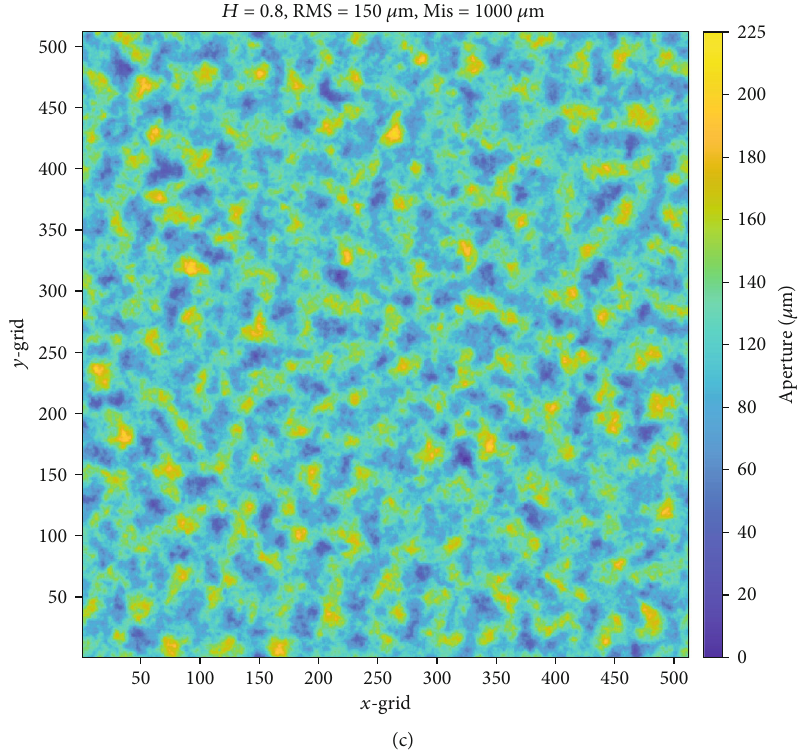
Figure 15: E ff ect of the RMS value on the aperture fi eld. H = 0 : 8 and λ = 1000 μ m . The scale of the color bar is proportional to the RMS c value. The number of grids in the x and y directions is 512. (a) Aperture fi eld when RMS = 50 μ m , which corresponds to surface pair 2 in Table 2; (b) aperture fi eld when RMS = 100 μ m , which corresponds to surface pair 6 in Table 2; (c) aperture fi eld when RMS = 150 μ m , which corresponds to surface pair 7 in Table 2. The RMS value is increased from (a) to (c).